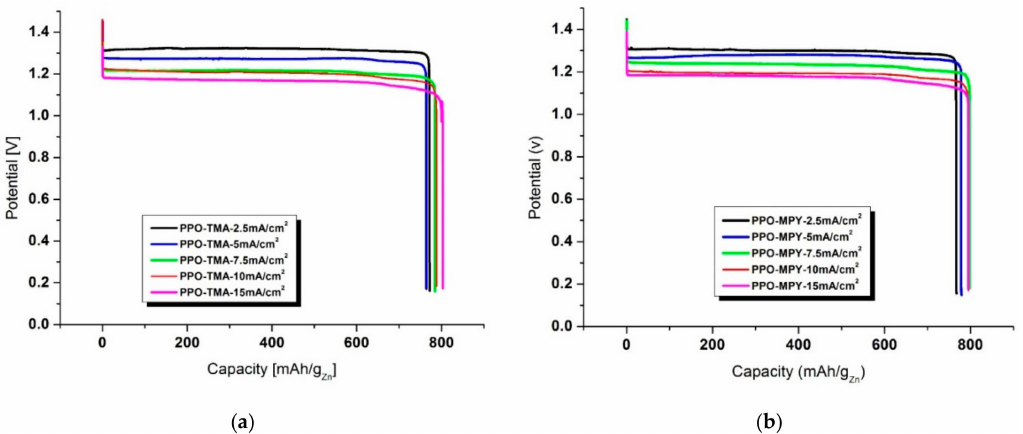
Figure 9. Galvanostatic discharge profile of the cell with PPO–TMA ( a ) and PPO–MPY ( b ) as a separator membrane at discharge current densities of 2.5 to 15 mA / cm 2